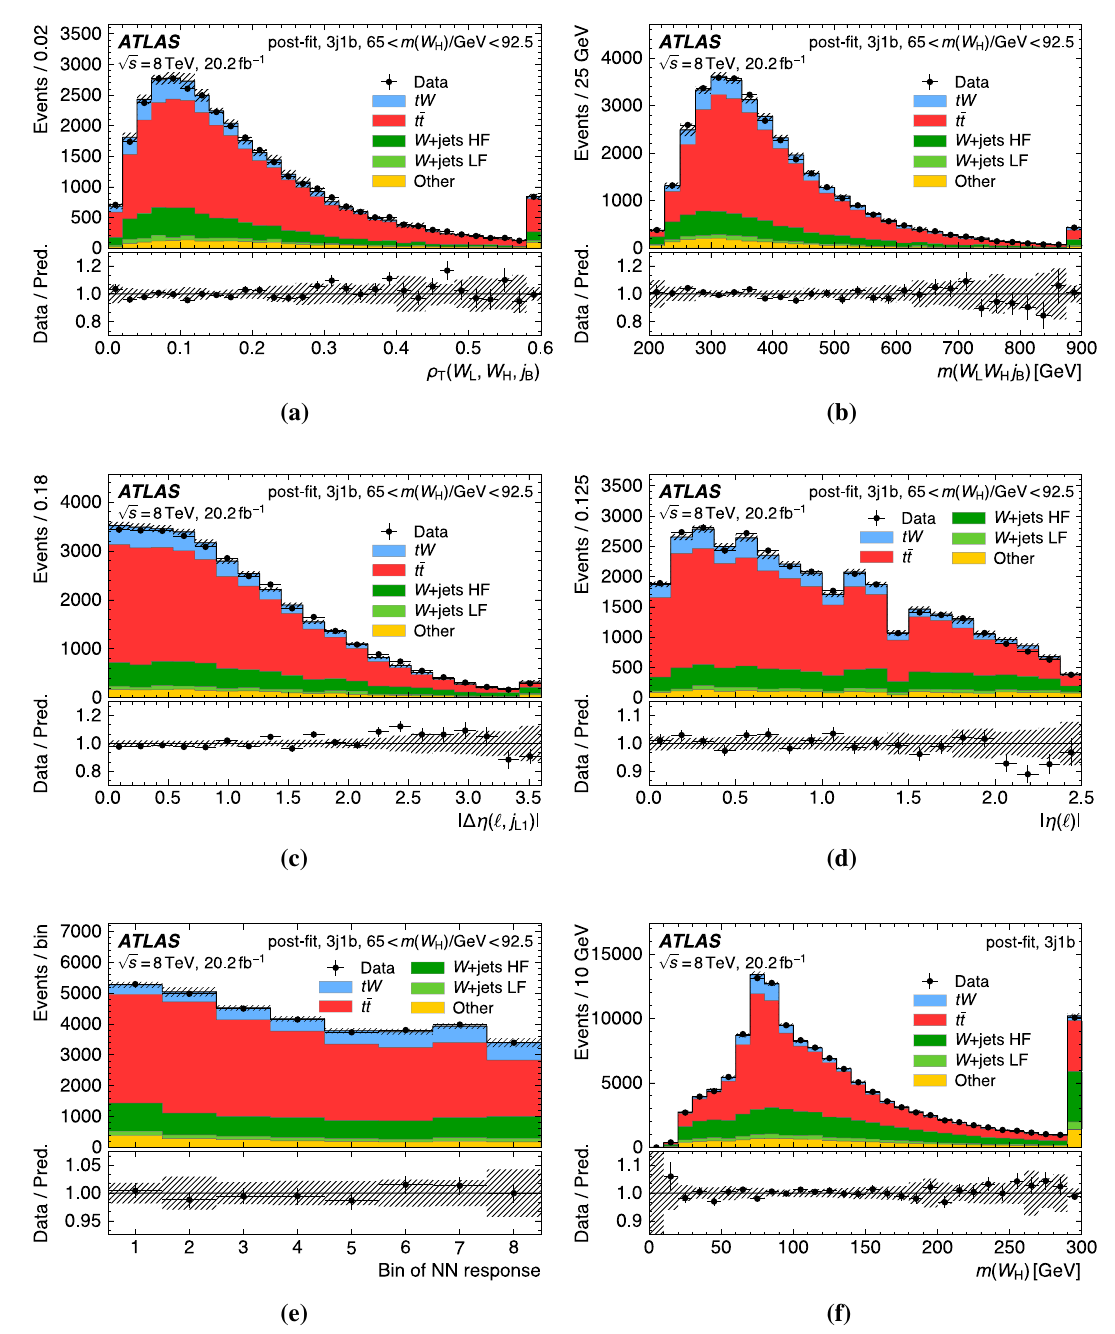
Fig. 7 a – d Post-fit distributions of the NN input variables, e NN dis- criminant and f m ( W H ) in the signal region. Small backgrounds are subsumed under ‘Other’. The dashed uncertainty band includes statis-